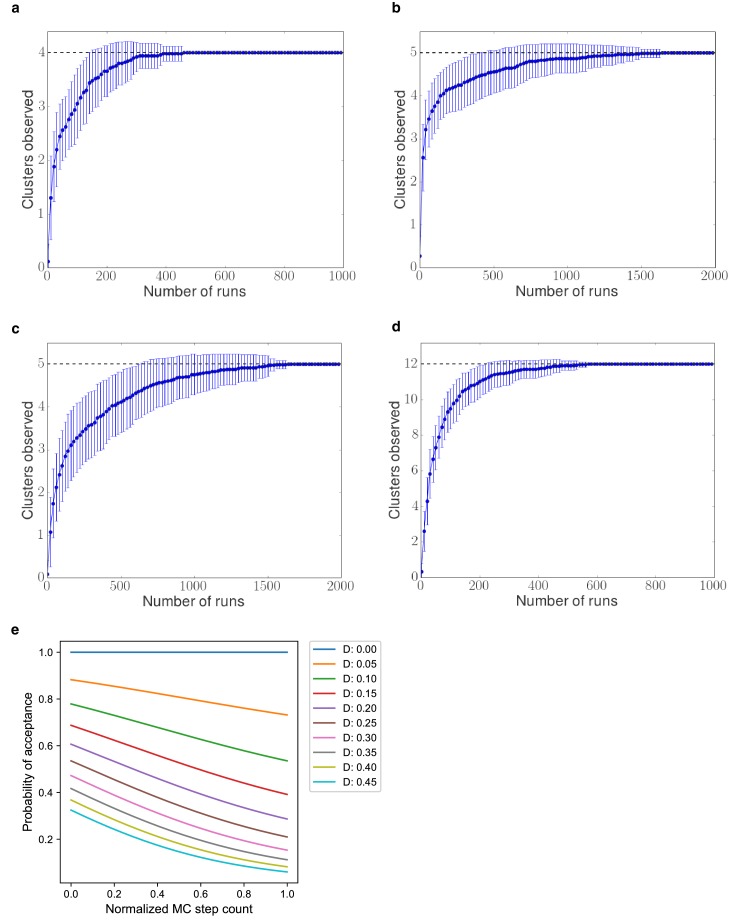
Sampling convergence test.Independent Monte Carlo sampling runs were performed, and the number of clusters of similar pathways for each number of runs was computed. (A) Glycolysis pathway, (B) CMP KDO-CMP biosynthesis pathway, (C) Serine synthesis pathway, and (D) L-gulonate catabolism pathway. (E) Probability of acceptance at the MC step in a sampling run, where D is the difference between the scores of the current pathway model and the new pathway model.